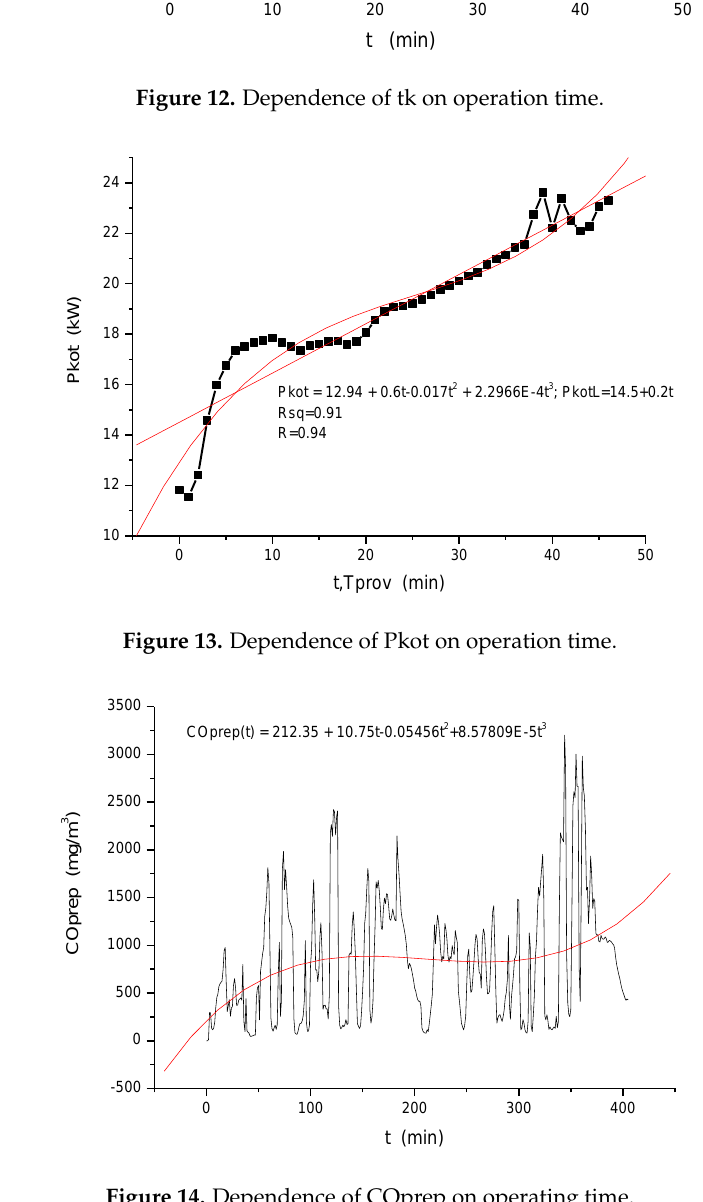
Figure 14. Dependence of COprep on operating time.